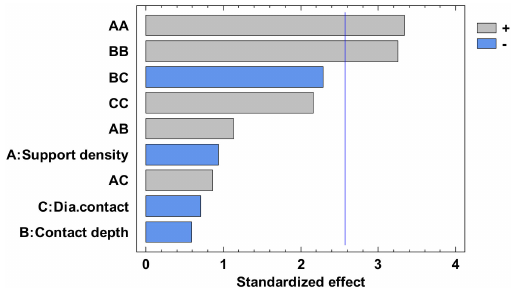
Figure 17. Standardized Pareto Chart for